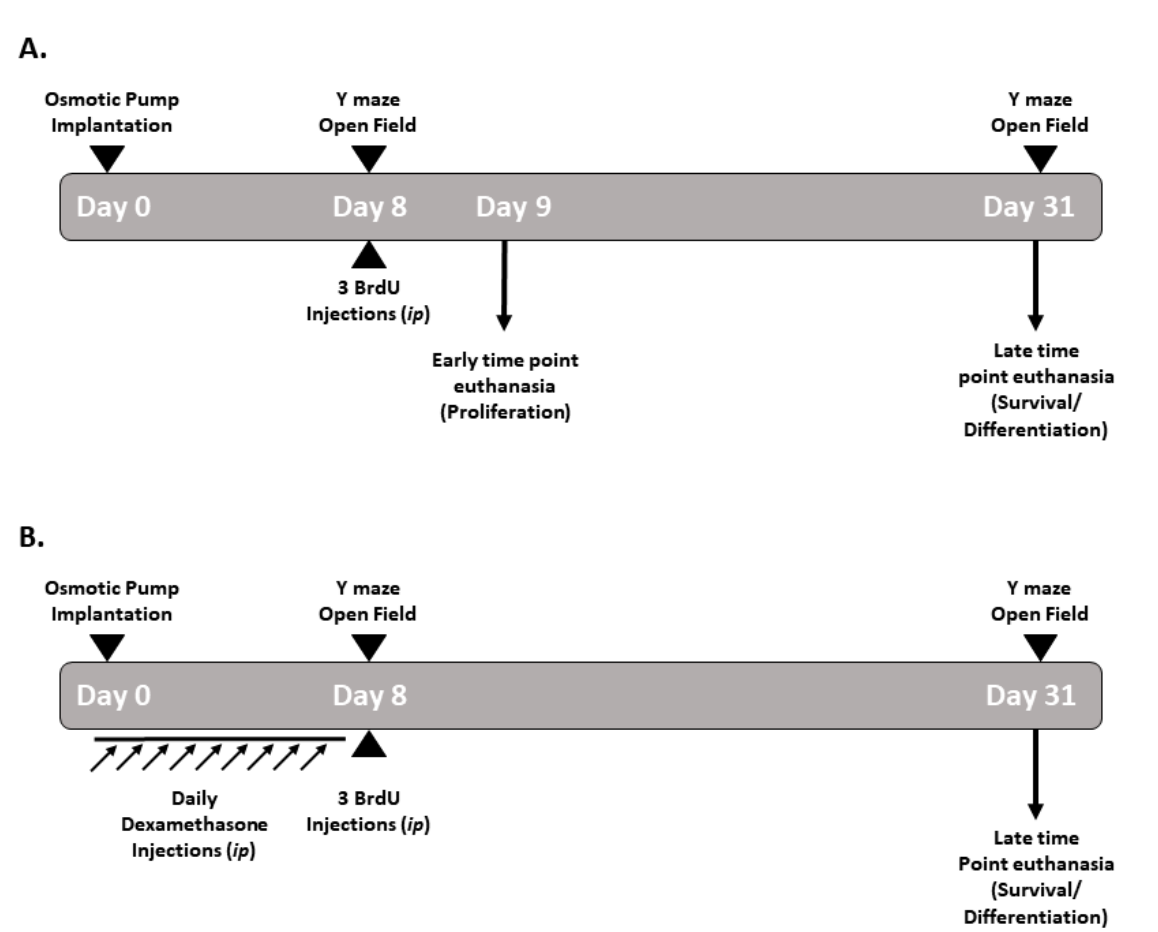
Figure 1. Diagrams showing the experimental timeline for continuous micro-perfusion of kainic acid using mini-osmotic pumps and other experimental procedures. ( A ) Experimental timeline for osmotic pump implantation, behavioral tests, BrdU injections and euthanasia for sham and KA groups and ( B ) for dexamethasone sham- and KA- treated groups.